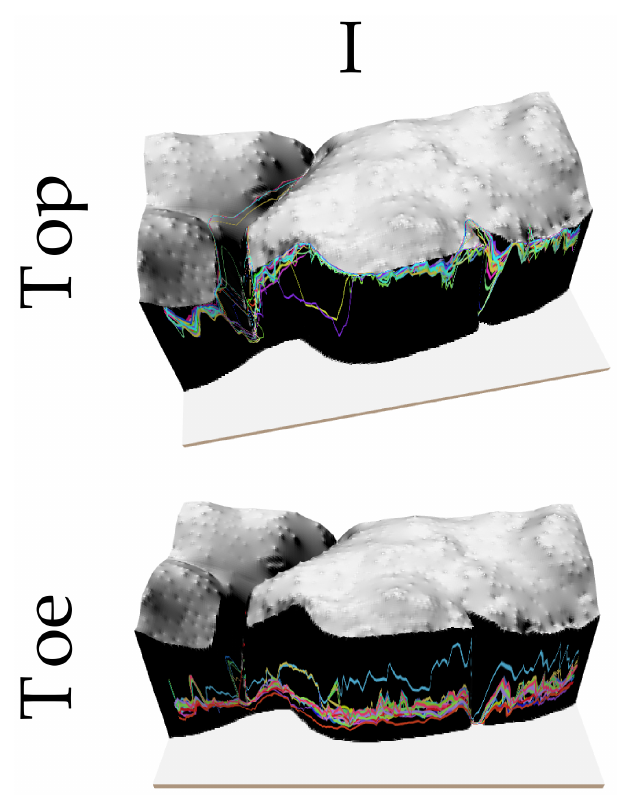
Figure 15. manually digitized cliff top and toe lines (coloured lines) over the DEM for the FH1 site. DEM colours represent slope (darker colours represent higher slopes). The vertical dimension has been exaggerated 10 times. The roman number represents the main cluster of manually digitized